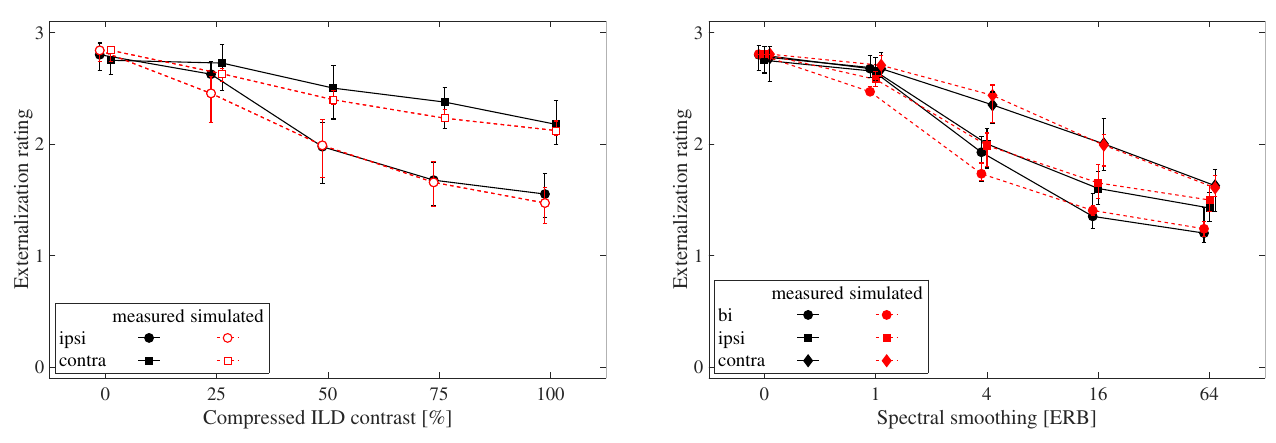
Figure 5. Median values of externalization ratings and the mapped results for reduced ILD contrasts with ipsilateral (condition “ ipsi ” ) versus contralateral (condition “ contra ” ) spec- tral distortions. All other conventions are as in Figure 2.